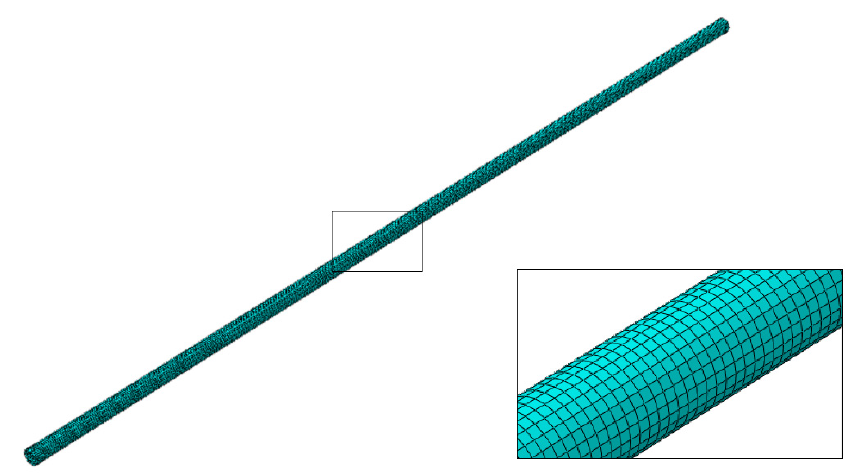
Figure 5. Detail of the mesh used in the representative geometry.